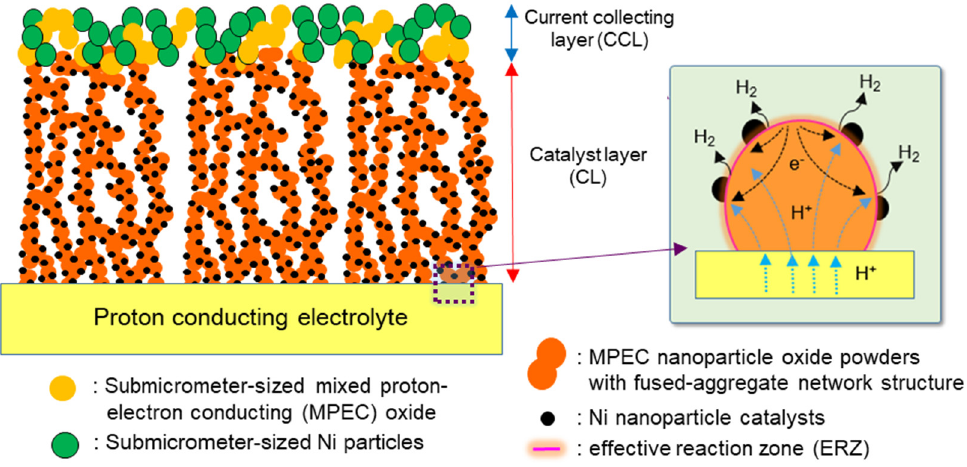
Figure 1. Schematic image of double layer (DL) electrode for proton-conducting solid oxide electrolysis cells (SOEC).